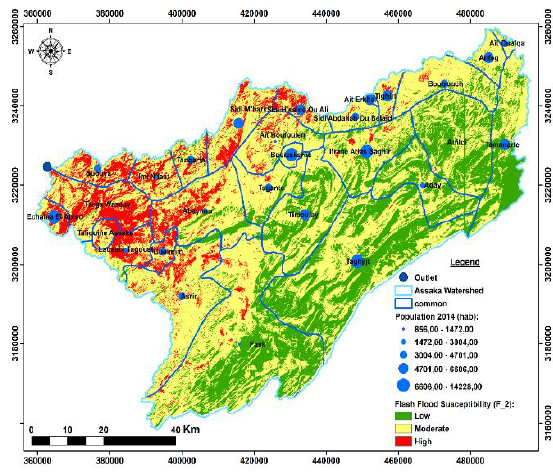
Figure 5. The residential population in a flash flood Susceptibility